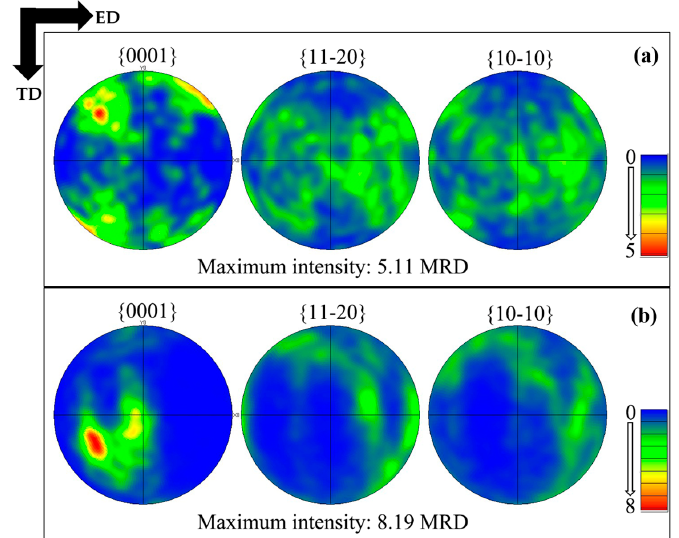
Figure 4. Pole figures of ( a ) 0-pass (as-extruded); and ( b ) 4-pass ECAP alloys (the dates are from the electron back scattered diffraction measurements).